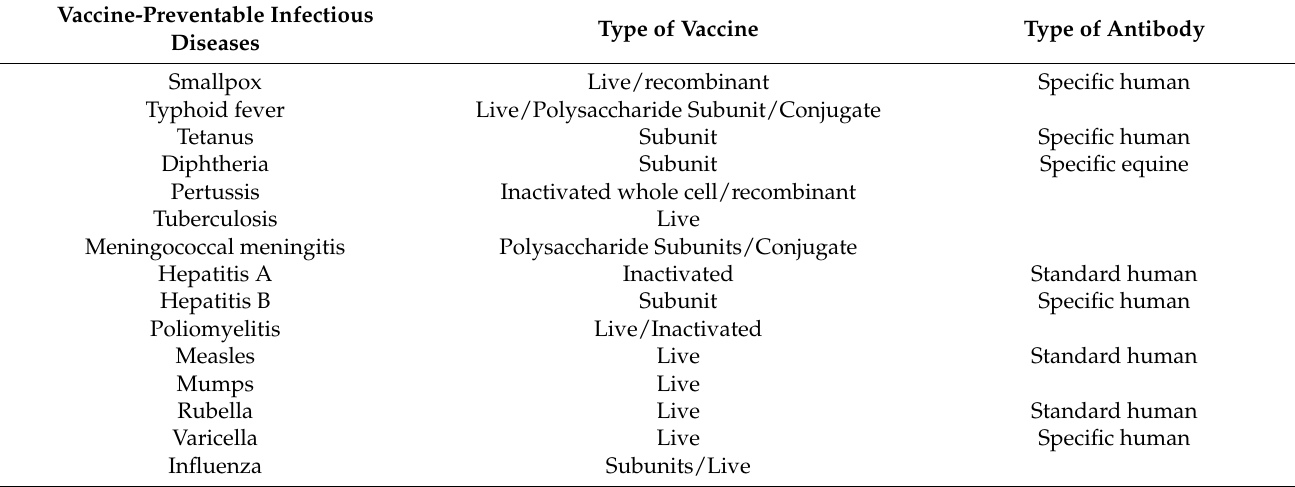
Table 2. Infectious diseases and available vaccines and antibodies for prophylaxis and